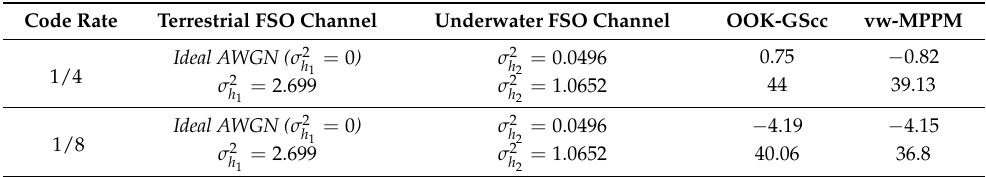
Figure 6. Analytical ABER and Monte Carlo simulation results (circles) vs. SINR γ 0 for a vw-MPPM = 0.0496), weak-to-moderate ( σ 2 = 0.2453) and format with code rate of 1/8 under weak ( σ 2 h 2 h 2 = 1.0652) salinity-induced turbulence and different Málaga turbulence intensities in the strong ( σ 2 h 2 terrestrial FSO link. Scenarios and values of irradiance variances in the underwater medium taken from acquired data presented in [68]. In solid lines, the performance of the system when only oceanic turbulence is considered is represented. Table 2. SNR ( γ 0 ) [ dBs ] for achieving an ABER of 10 − 4